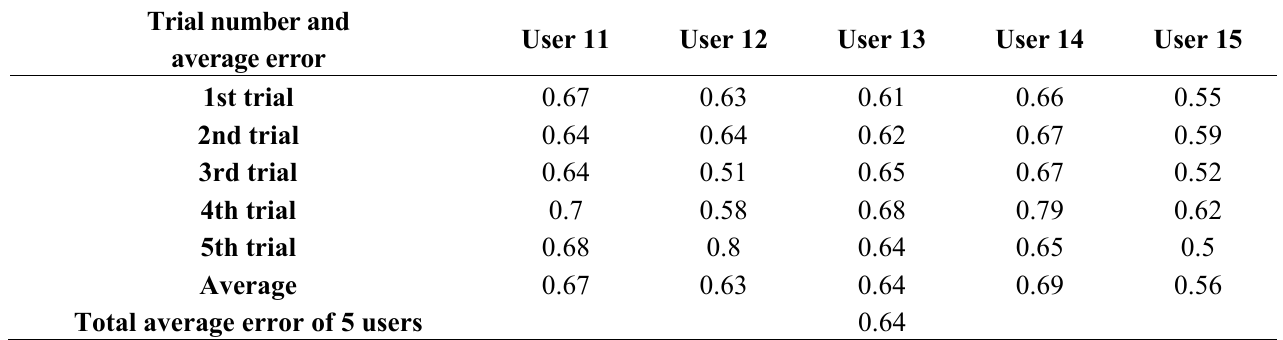
Table 13. The gaze detection errors for users who were wearing glasses (units: °). Trial number and average